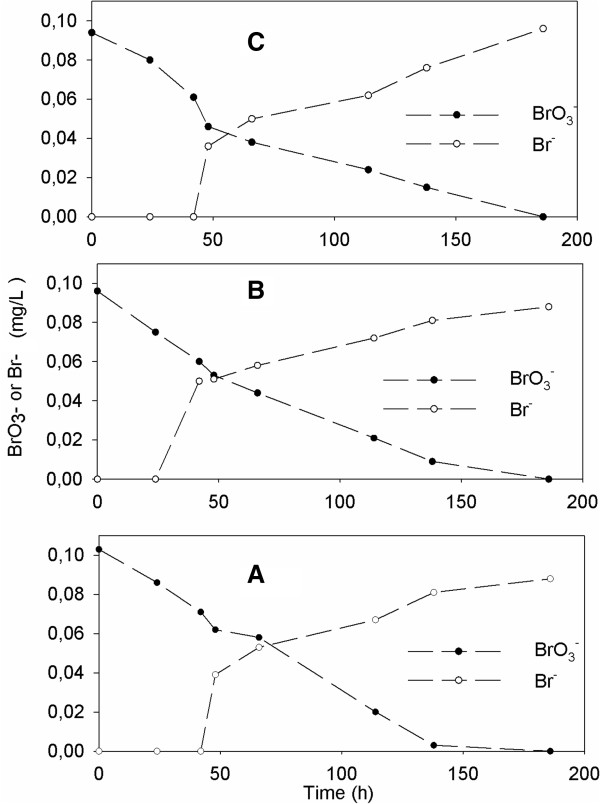
The variations of BrO3- in batch experiments at different initial NO3--N concentrations [100 μg/L BrO3-]. (A) 25 mg/L NO3--N; (B) 50 mg/L NO3--N; (C): 75 mg/L NO3--N.